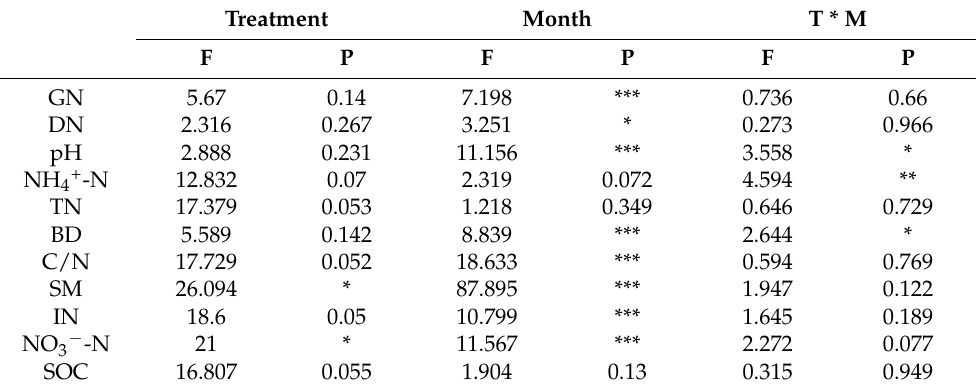
Table 1. Effects of treatment (T), month (M), and their interaction on gross nitrification (GN), deni- trification (DN), and soil physical and chemical properties in a desert steppe, based on a repeated- measures analysis of variance.